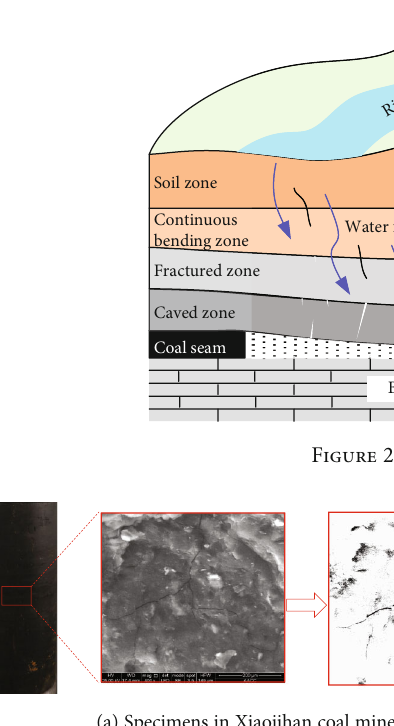
Figure 3: Initial microstructure of